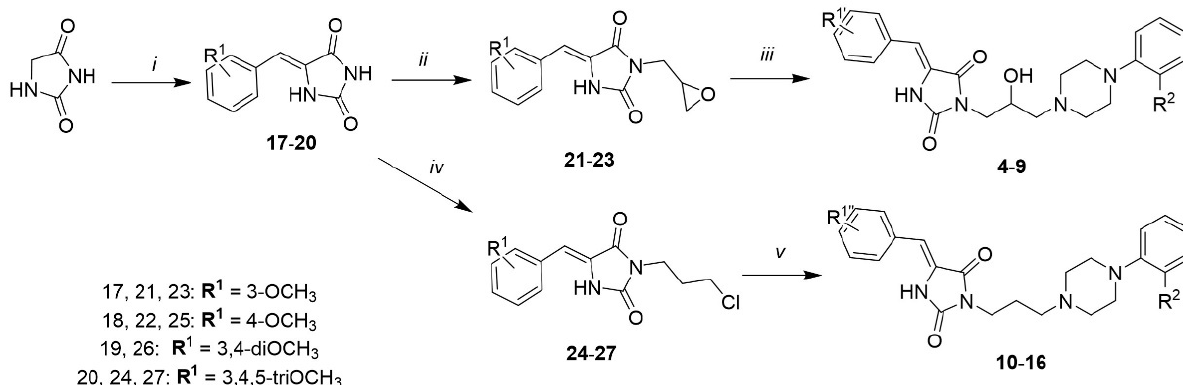
Figure 4. The herein investigated chemical